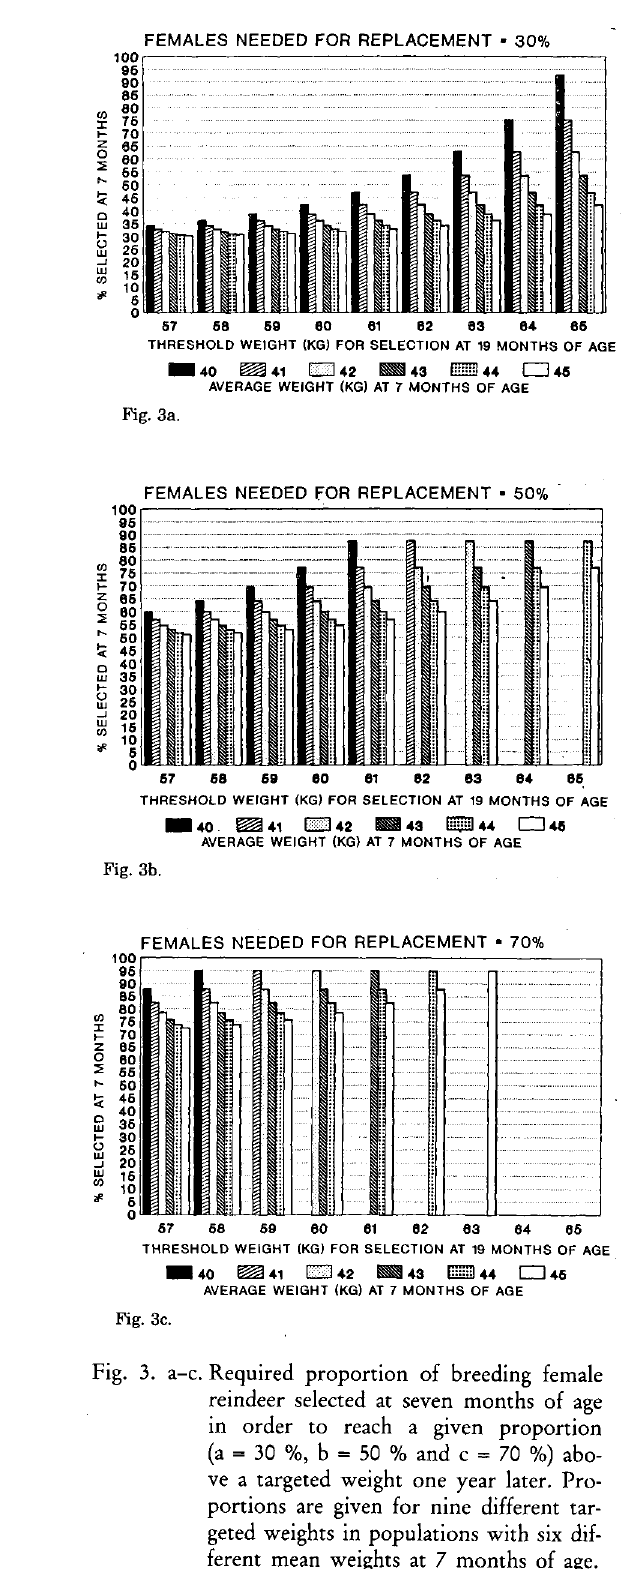
Fig. 3. a-c. Required proportion of breeding female reindeer selected at seven months of age in order to reach a given proportion (a = 30 %, b = 50 % and c = 70 %) abo ve a targeted weight one year later. Pro portions are given for nine different tar geted weights in populations with six dif ferent mean weights at 7 months of